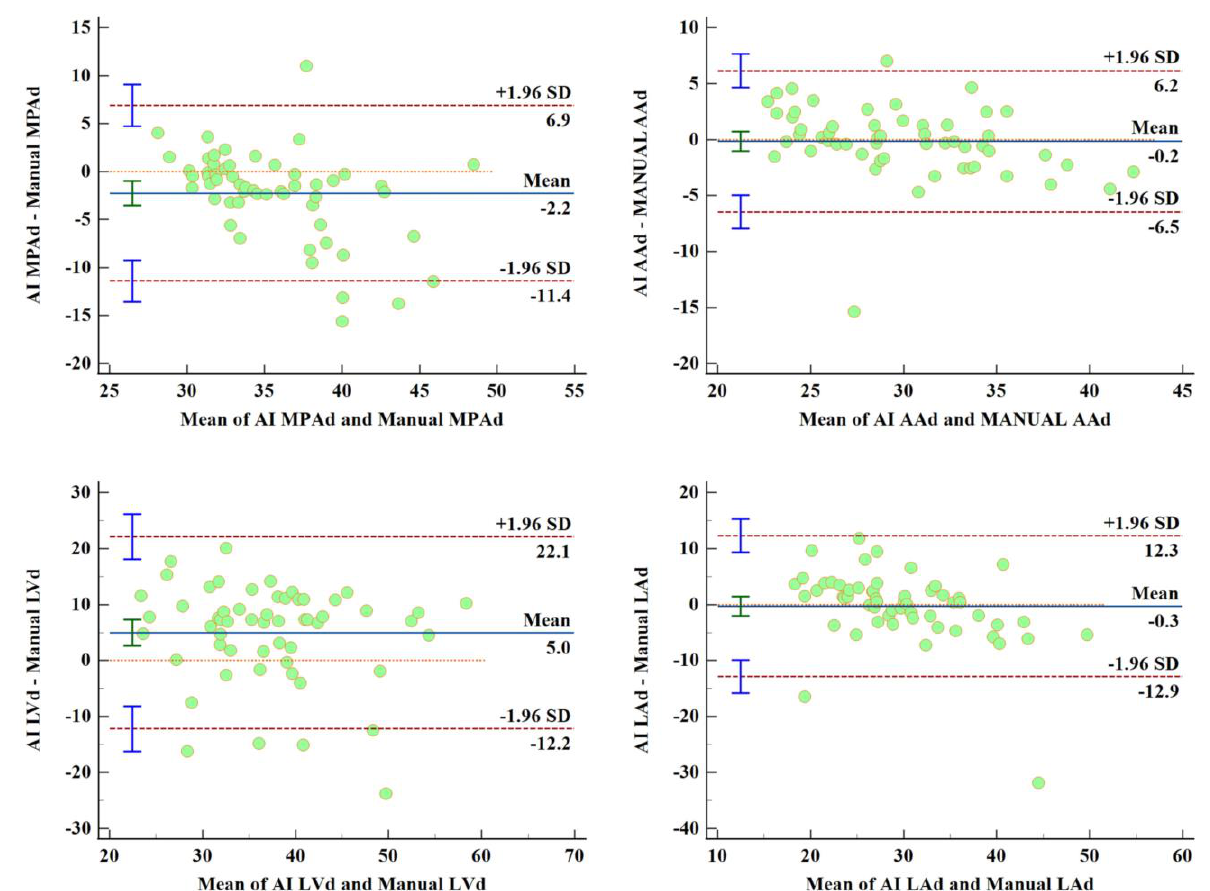
Figure 5. Bland–Altman analyses for features assessed by AI automatic and manual measurements show that the metrics measured by our automatic measurement method are in accordance with the ground-truth measured manually by experienced physicians.